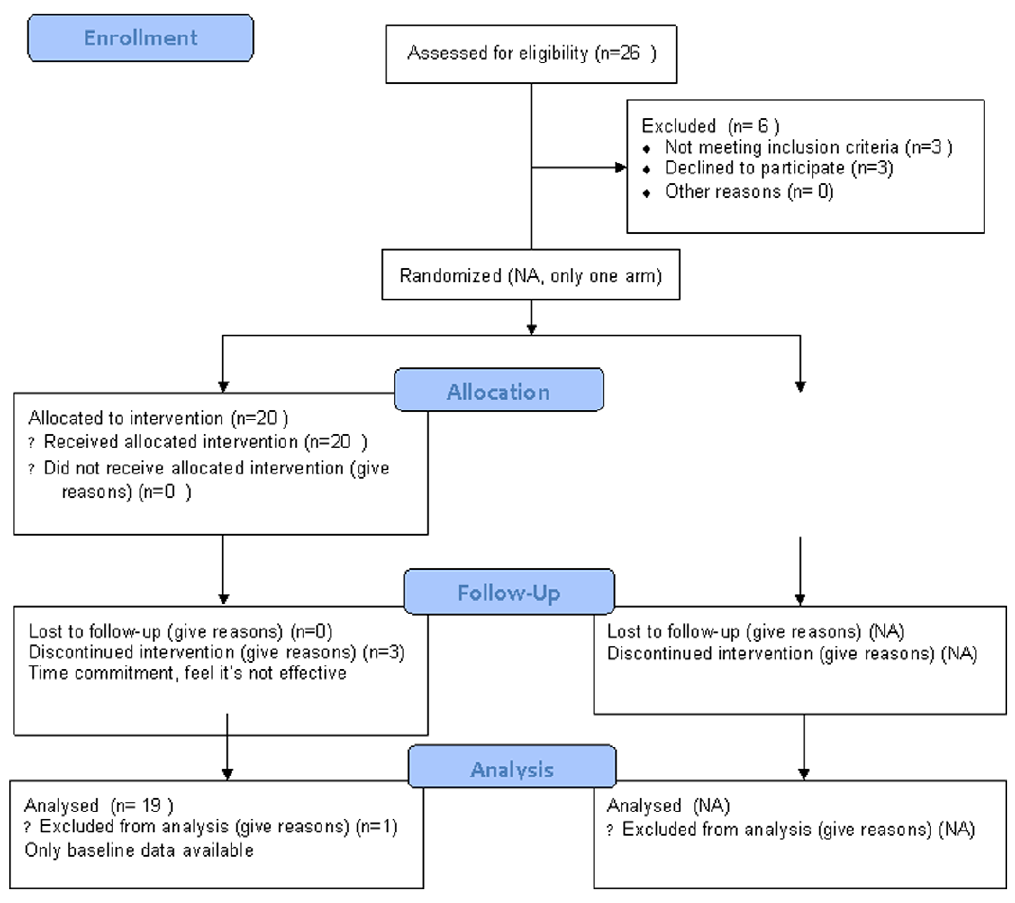
Figure 1. CONSORT flow diagram.